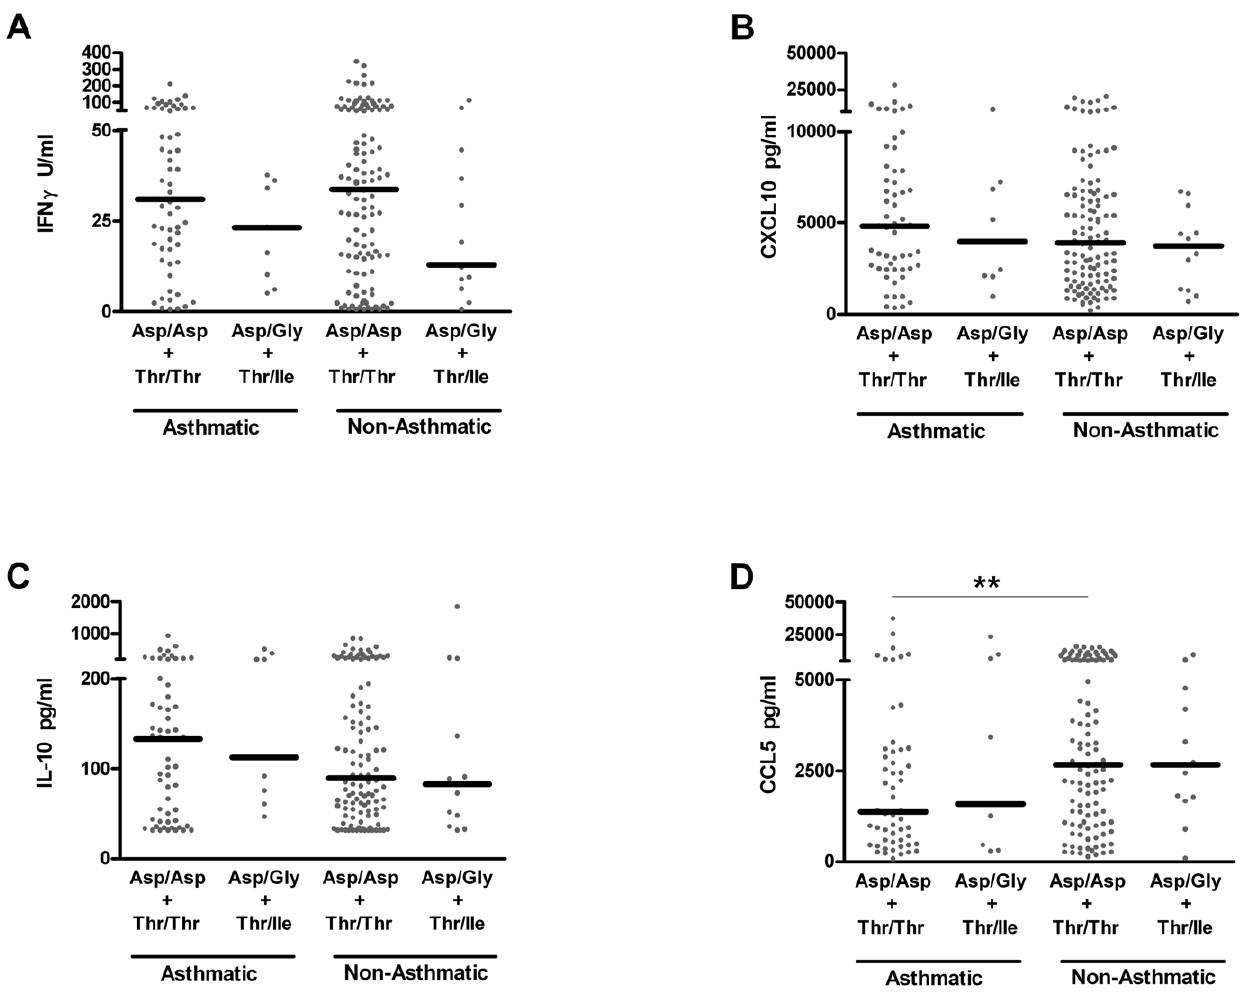
Figure 5. RSV stimulated cytokine responses in children or without current asthma are not influenced by TLR4 haplotypes. IFN c ( A ), CXCL10 ( B ), IL-10 ( C ) and CCL5 ( D ) were measured by ELISA in supernatants from 6 day PBMC cultures. Black bars represent median responses, each from an individual child ( N ). ** P , 0.01, with all other comparisons P . 0.05.